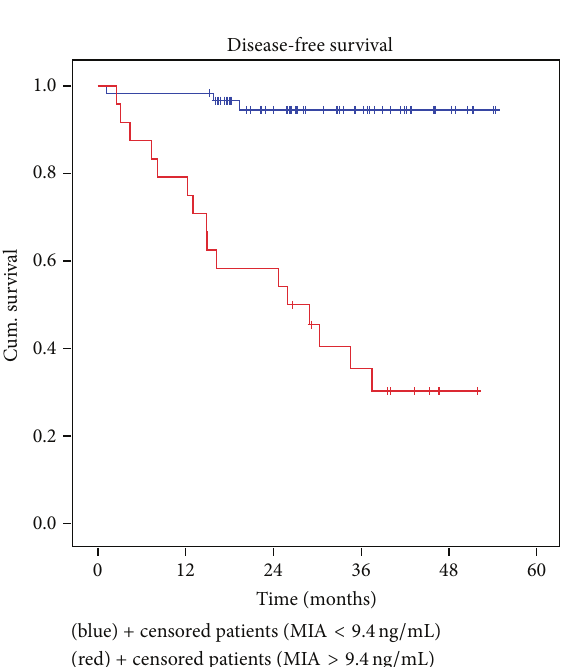
Figure 2: Kaplan-Meier disease-free survival for all stages I and II patients depending on MIA serum concentration. Red line: MIA serum concentration ≥ 9.4 ng/mL; blue line: MIA serum concentration < 9.4 ng/mL; 𝑃 = 0.000